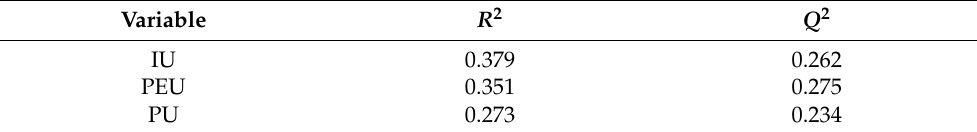
Table 8. R 2 and Q 2 effect